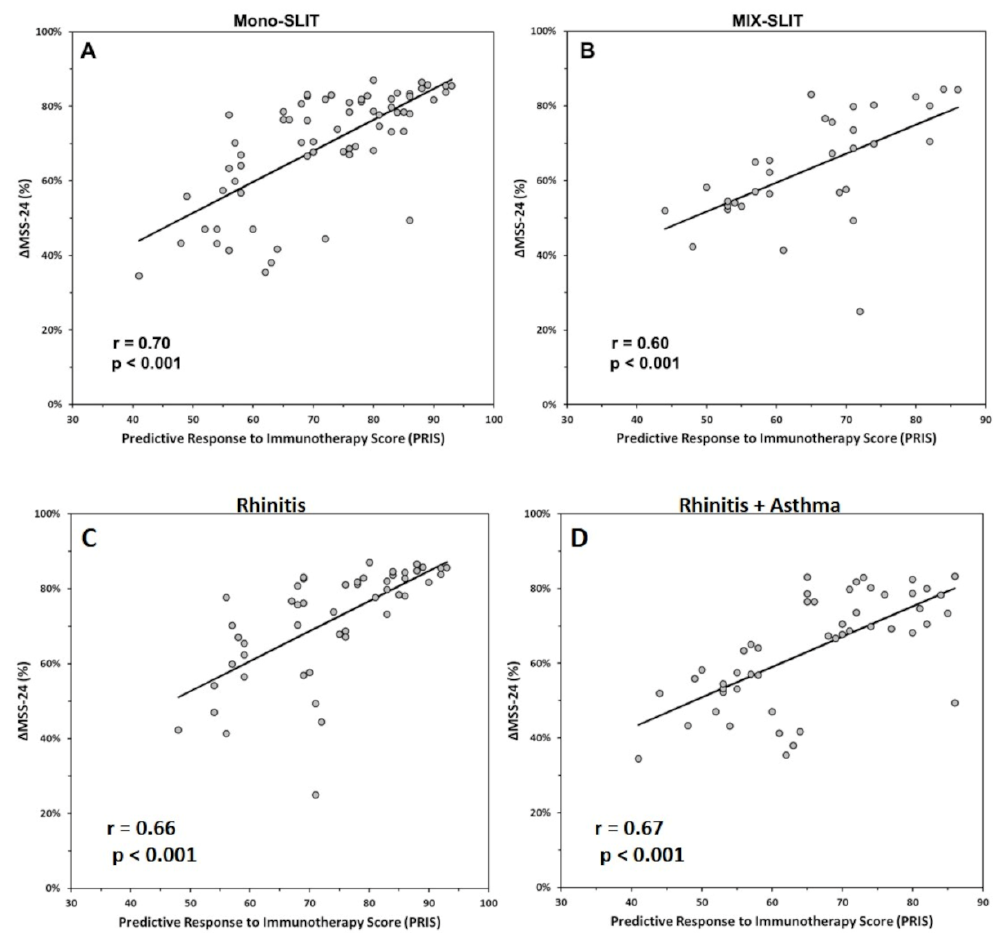
Figure 3. Correlation analysis revealed a significant direct correlation between the Predictive Re- sponse to Immunotherapy Score (PRIS) and ∆ MSS-24 for both patients treated with single-allergen ( A ) and multiple-allergen ( B ) sublingual immunotherapy (SLIT) ( p < 0.001), and between PRIS and ∆ MSS-24 for both patients with only rhinitis ( C ) and with both asthma and rhinitis ( D ) ( p < 0.001). Table 4. Linear regression models using as predictors all PRIS parameters. PRIS